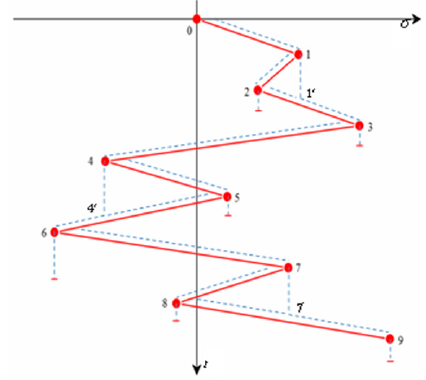
Figure 2. Load-time history.